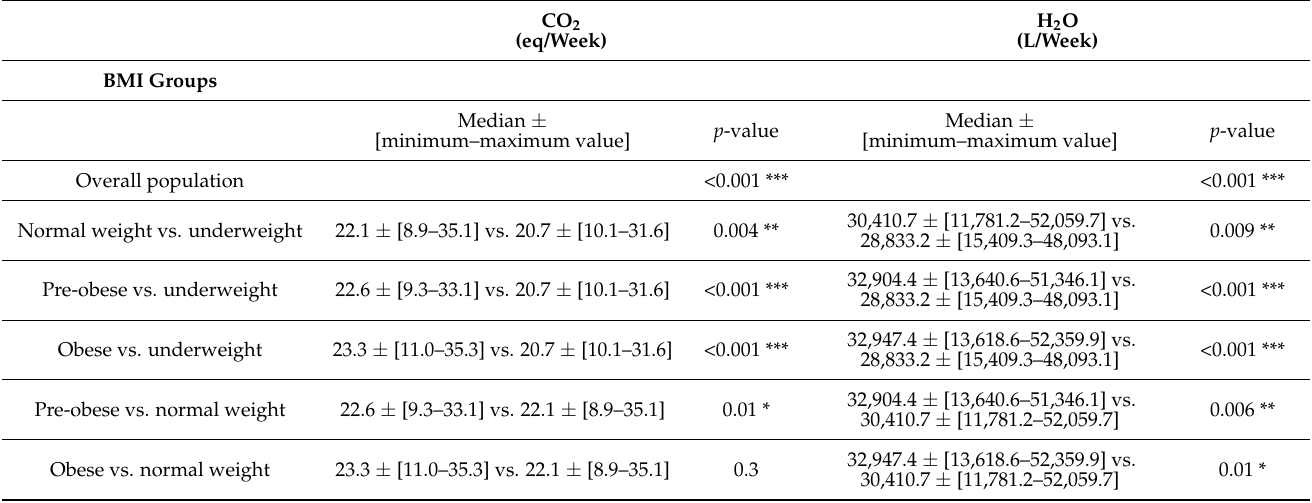
Table 2. Comparisons between the BMI groups for CO 2 and H 2 O. Values are expressed as median, minimum, and maximum values (median ± [min.–max. value]) for continuous variables.